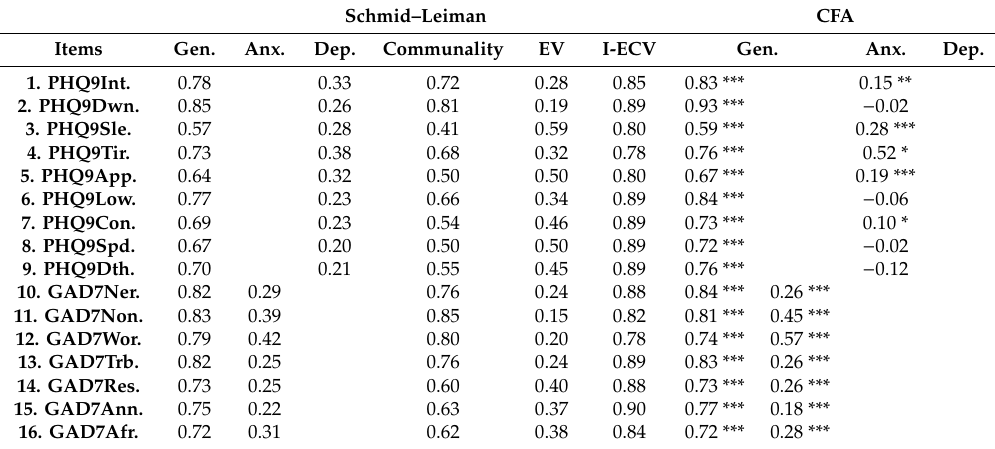
Table A2. Standardized Factor Loadings for the General Factor and the Two Sub-Factors of Depression and Anxiety in Omega Test and CFA. Schmid–Leiman CFA